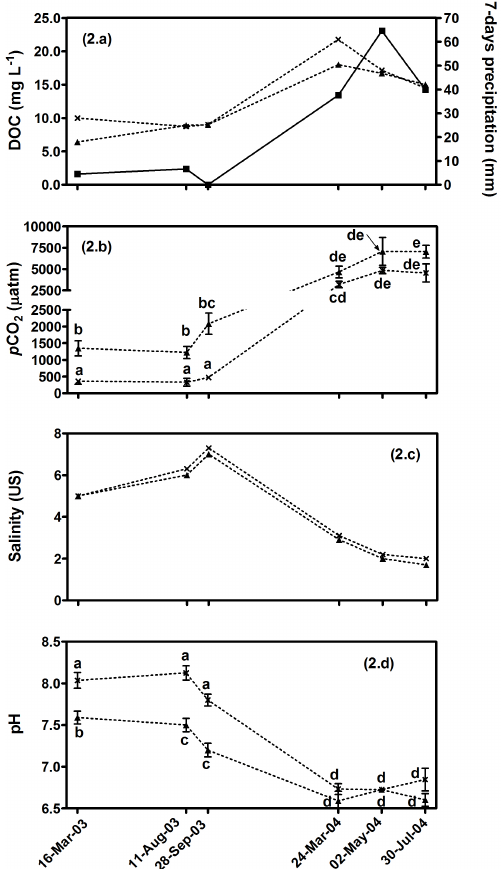
Fig. 2. Accumulated precipitation in the week preceding the sam- pling (full squares) and average DOC concentrations (a) , p CO 2 (b) , salinity (c) and pH (d) in open waters (triangles) and macrophyte- covered (crosses) waters of Lake Carapebus along the studied pe- riod. Bars indicate standard errors and at least a letter shared by different dates indicates no significant differences (Tukey-Kramer, p < 0 . 05) for pH and p CO 2 among stations and sampling